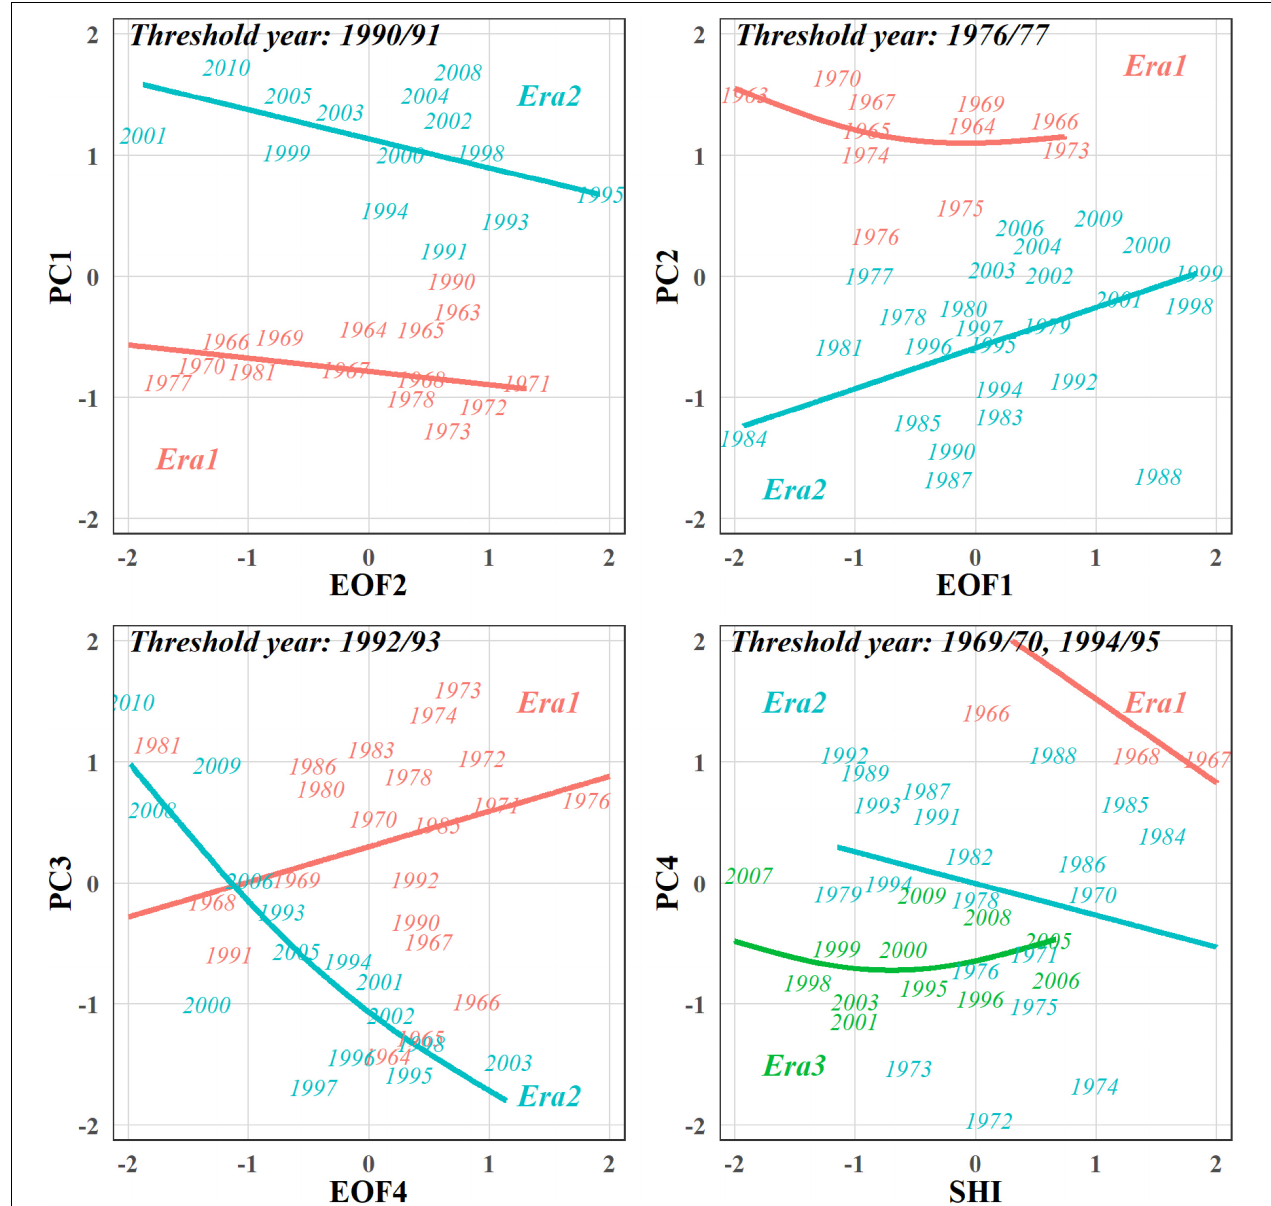
FIGURE 9 | Fitting relationships by the best fitted models. Colors represent different eras with distinguished